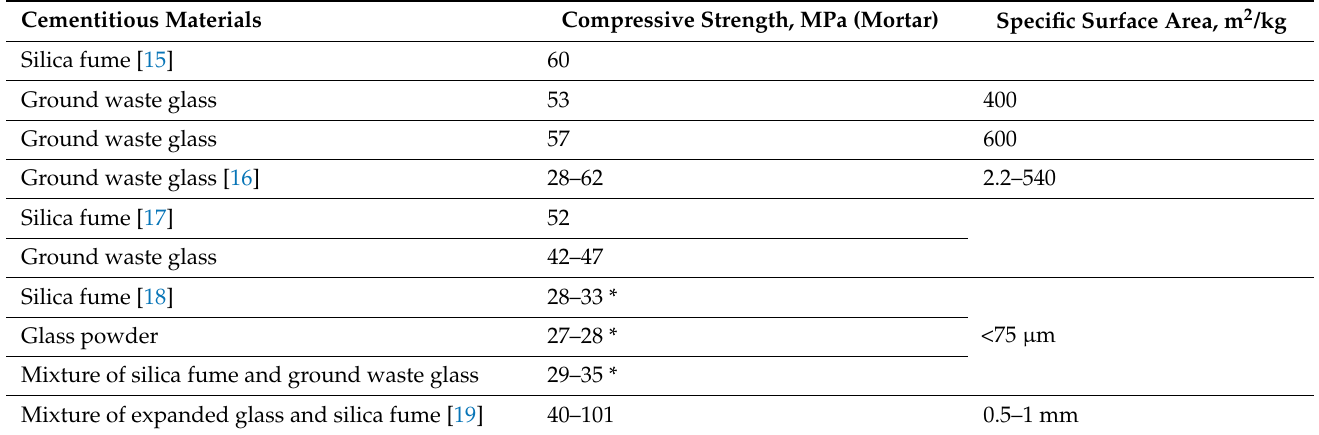
Table 1. The compressive strength of mortar with silica fumes and ground waste glass as cementi- tious